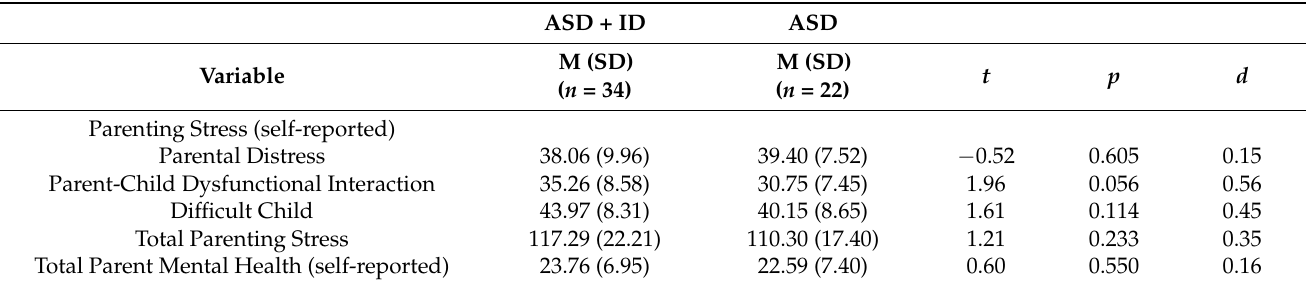
Table 3. Group Comparisons of Parenting Stress and Parent Mental Health. ASD +